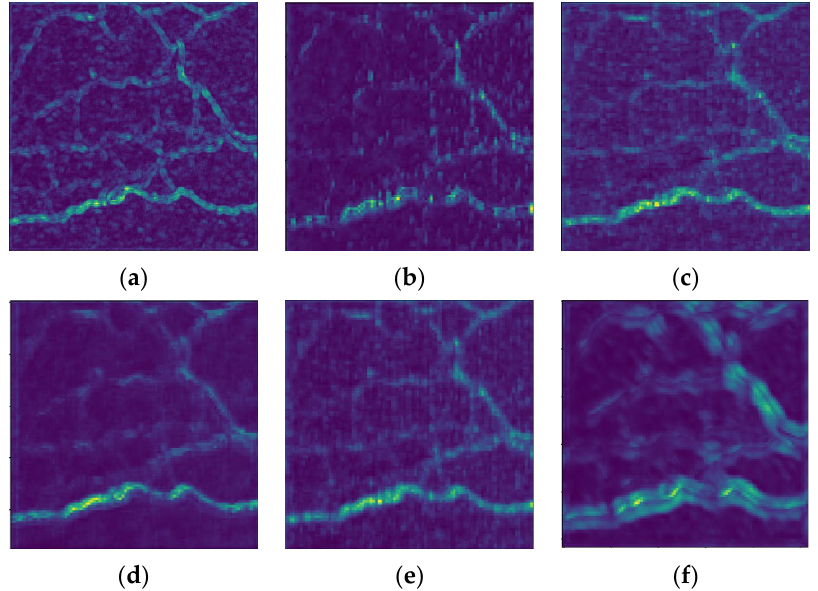
Figure 11. ( a ) Input-fused image of feature maps; ( b ) fused image of feature maps after 1 × 3 convolutions extraction; ( c ) fused image of feature maps after 3 × 1 convolutions extraction; ( d ) fused image of feature maps after 3 × 3 convolutions extraction; ( e ) fused image of feature maps after parallelization of 1 × 3, 3 × 1, and 3 × 3 convolutions extraction; and ( f ) fused image of feature maps extracted by the ACE module. The above pictures are represented using 32 bits.